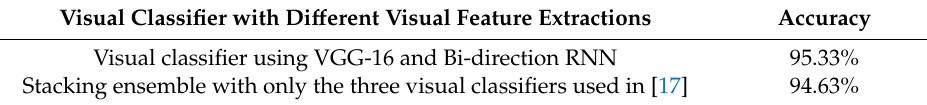
Table 1. Detection accuracy comparison based on visual features.